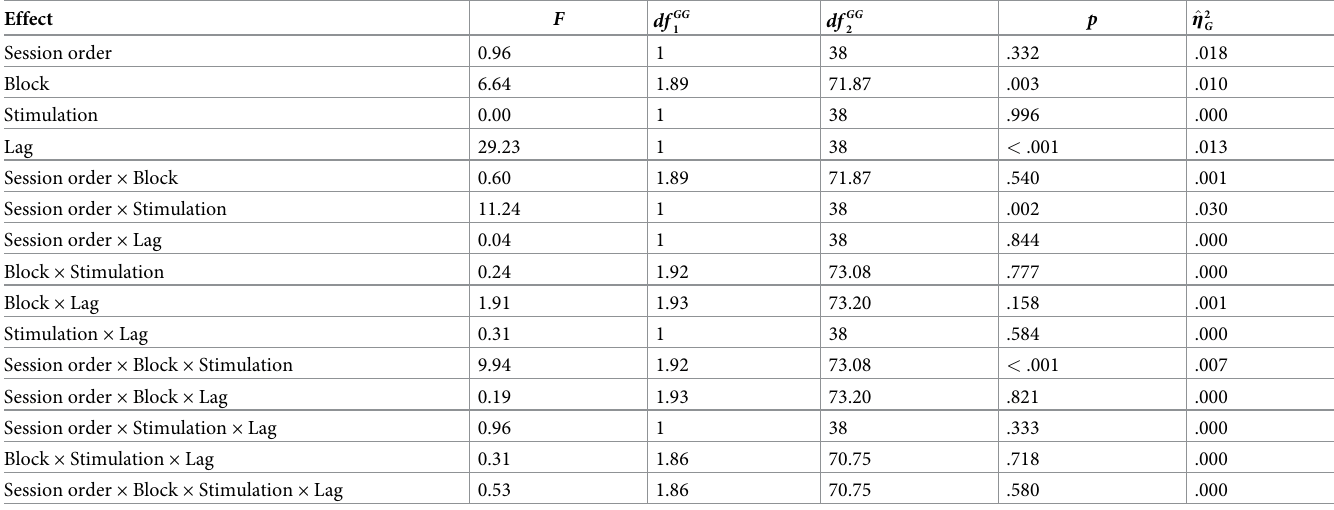
Table 3. Repeated measures ANOVA on T1